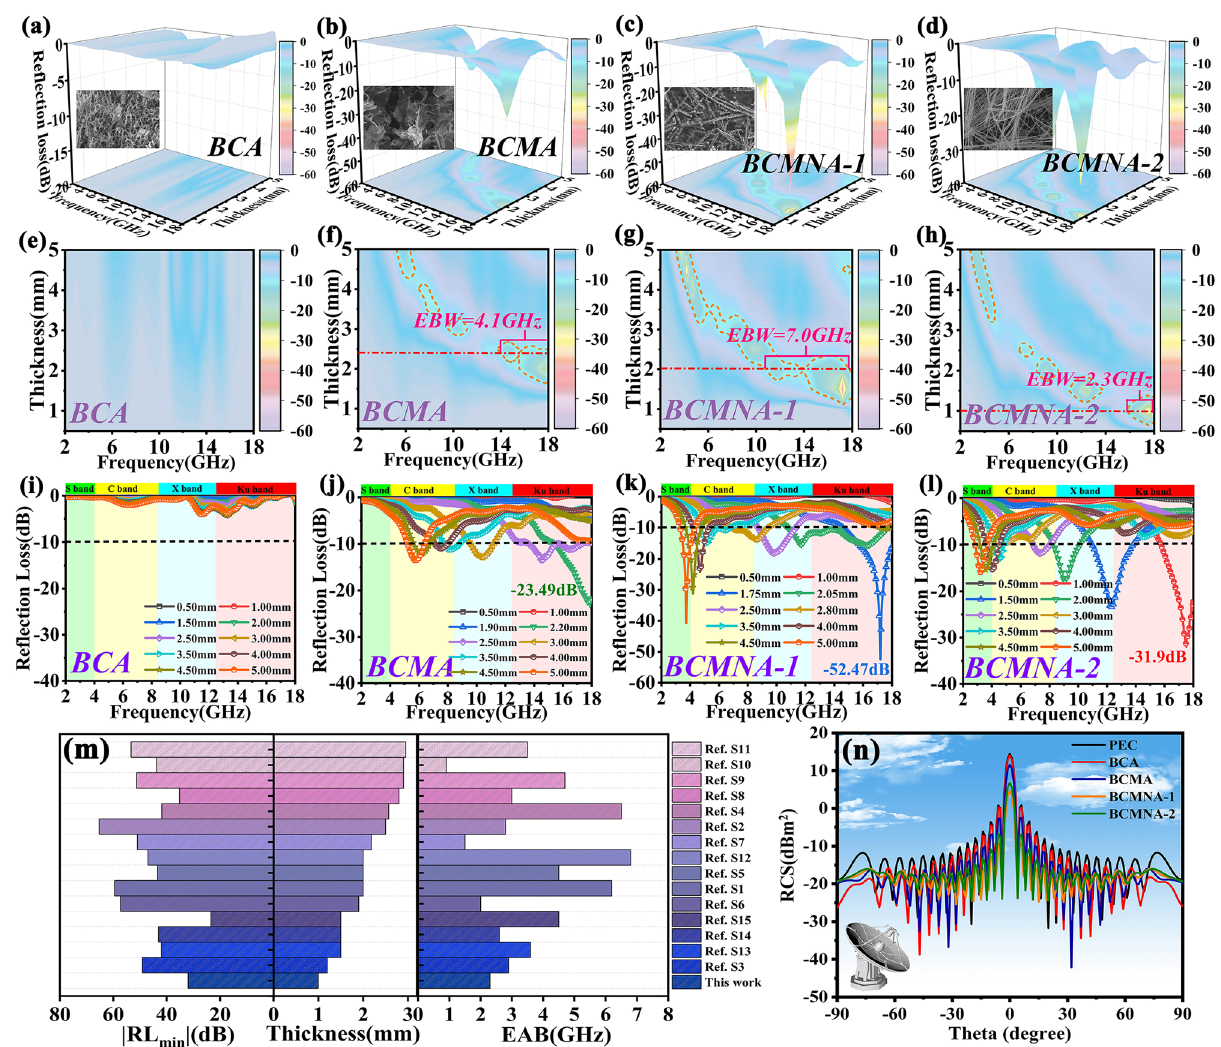
Fig. 4 3D RLs-f curves, corresponding contour map and 2D RLs-f curves of a , e , i BCA, b , f , j BCMA, c , g , k BCMNA-1, and d , h , l BCMNA-2 with 15 wt% filling ratios under 0.5–5.0 mm; m comparison image of similar reported EMW absorbing materials; n RCS simulated curves of samples-PEC composites and pure PEC with scanning angles from − 90° to